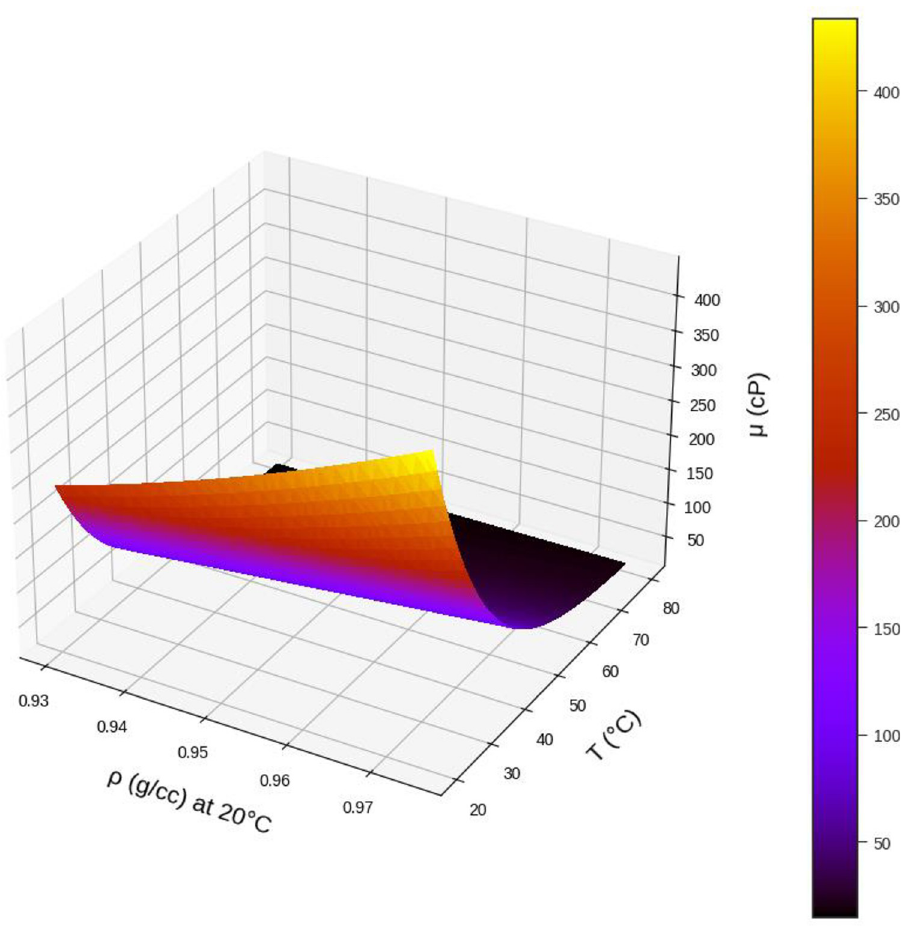
Fig 10. Effect of temperature and ρ (g/cc) on the output. API = 18.6, %C4 = 0.35, %C5 = 1.62, %C6 = 3.21, %C7+ = 94.81, MWC7+ = 338.41, SGC7+ =